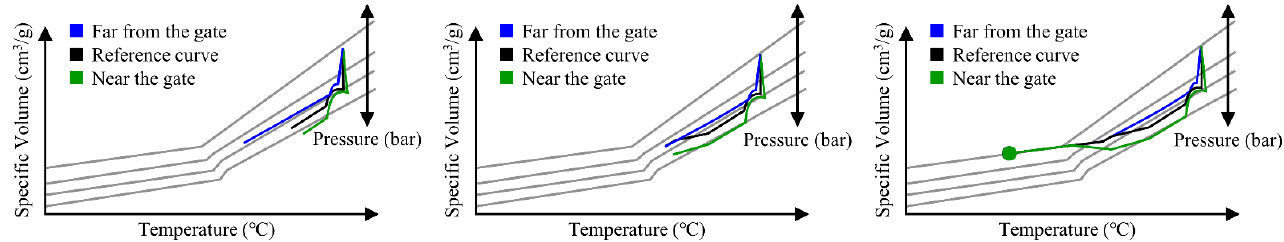
Figure 13. Optimization concept for packing pressure adjustment by the PVT processing path.